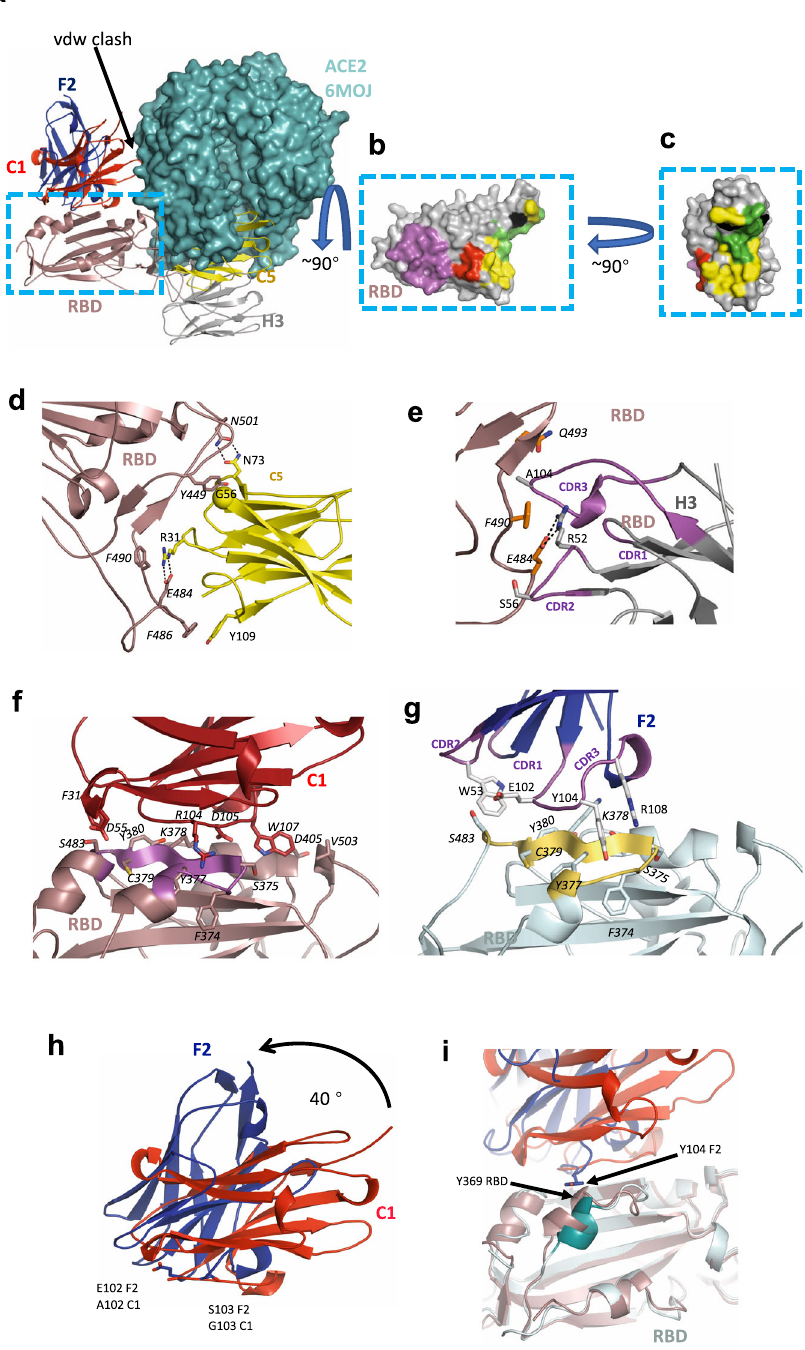
Fig. 2 Crystal structures of nanobody-RBD complexes. a The four nanobodies of this study are shown in cartoon and labelled. The fi gure was generated by superimposing the RBD protein from each crystal structure, only one RBD monomer is shown. Also shown is ACE2 (cyan surface) from the RBD ACE2 complex (PDB 6M0J), positioned by superposition of the RBD. Nanobodies C5 and H3 compete with ACE2 for binding to RBD. F2 and C1 bind to a different epitope, although a loop of C1 (G42) would clash with ACE2 (arrow). b RBD is shown as a surface, the RBD molecule has been rotated by 90° relative to a . The surface is coloured magenta corresponds to the epitope engaged by both C1 and F2, in red is the additional region recognised by C1 only. In yellow is the epitope recognised by C3 only, in black by H3 only and in green by both C5 and H3. c The same molecule and colour scheme as b but rotated by 90° to more clearly show the H3 and C5 epitopes. The key molecular interactions between d C5, e H3, f C1, and g F2 and RBD are identi fi ed and labelled. RBD is in approximately in the same orientation as a . In f and g coloured in magenta and gold respectively is the portion of RBD that is also recognised by both C1 and F2. h C1 and F2 bind to RBD in different orientations and overlap at residues 102 and 103. Their spatial relationship can be described as an approximate 40° rotation around the main chain at 102 and 103. i In the F2 (blue) RBD (cyan) complex, Y102 of F2 results in a displacement of the helix at Y369 of RDB relative to the C1 (red) and RBD (brown) complex. The orientation of the molecules are the same as shown in Fig. 2a. All structural fi gures were prepared using PyMOL (http://www.pymol.org/).